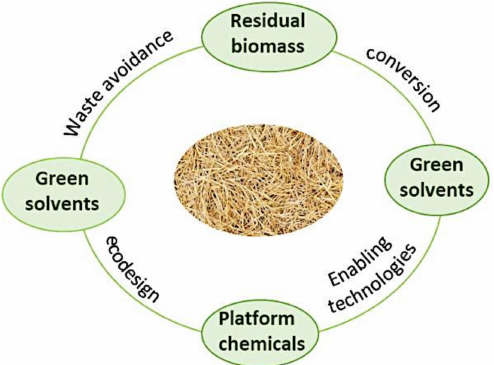
Figure 1. Circular economy in the biomass valorisation using biomass-derived green solvents. Solvents derived from biomass (especially hemicellulose and lignin) including γ -valerolactone (GVL) [11,12], 2-methyltetrahydrofuran [13], tetrahydrofuran (THF) [14], ionic liquids (ILs) [15] and deep eutectic solvents (DESs) [16,17] have been successfully applied in biomass pretreatment and